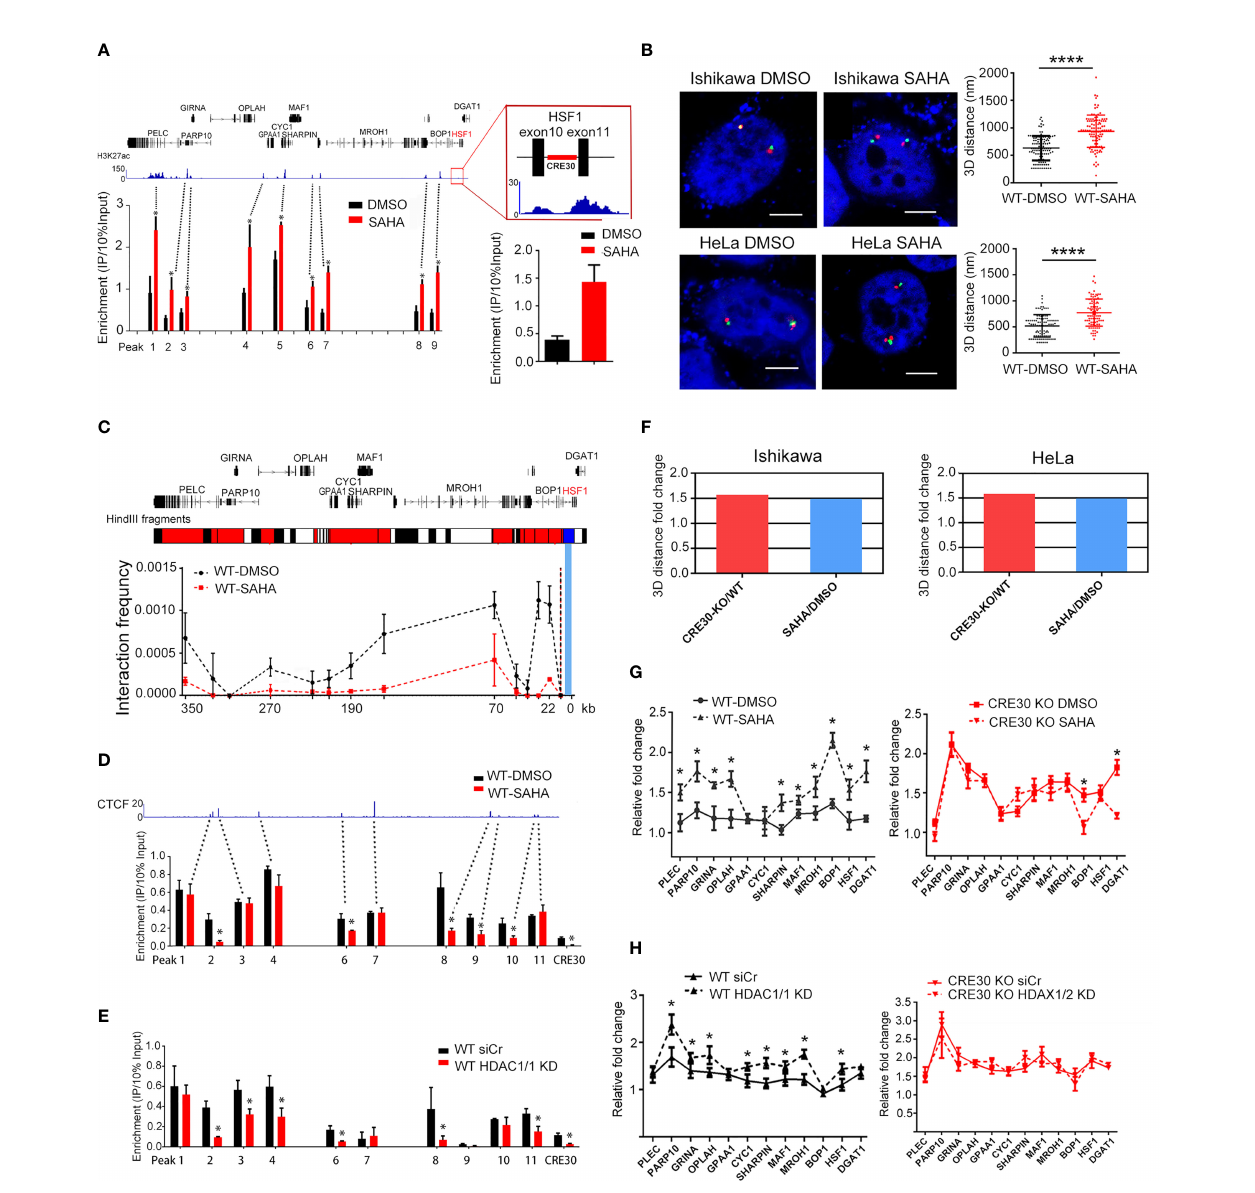
FIGURE 5 | Histone acetylation affects chromatin architecture and regional gene regulation in sub-CRR95. (A) H3K27ac ChIP-qPCR experiments were performed in Ishikawa cells following SAHA treatment. Primers were designed on modi fi cation peak loci obtained from ChIP-seq data in uterus (ENCFF405MES, ENCODE). Peak number corresponds to primers listed in Supplementary Table 1 . A signi fi cant increase of H3K27ac levels was detected in the SAHA treatment group (red bars) compared with the DMSO treatment group (black bars) (n = 3). Right panel zoom in the CRE30 locus. (B) Representative 3D-FISH images of Ishikawa cells (upper panel) and HeLa cells (lower panel) with DMSO or SAHA treatment. Boundary loci of sub-CRR (red and green) and DAPI (blue) are shown. Scale bars indicate 5 m m. Scatter diagrams on the right show the 3D distance between adjacent red and green spots, suggesting a signi fi cant increase after SAHA treatment in both cell lines. Approximately 90 – 120 loci were counted for each group. (C) Analysis by 3C-qPCR in Ishikawa cells at the sub-CRR95 region. The Hind Ш fragment bars on the top illustrate bait fragments (blue) and tested interaction fragments (red). Interaction peaks were detected in the DSMO group (black dotted lines), which decreased with SAHA treatment (red dotted lines) (n ≥ 2). (D, E) ChIP-qPCR assay showed that CTCF binding decreased widely following both SAHA treatment (D) and HDAC1/2 knockdown (E) in Ishikawa wild-type cells (n = 3). Primers designed on CTCF peaks according to ChIP-seq data in Ishikawa (ENCFF961BQG, ENCODE); peak number corresponds to primers listed in Supplementary Table 1 . (F) Based on the 3D distance that is obtained in the same batch of 3D-FISH experiments; fold changes of mean 3D distance were calculated in the CRE30 KO group (CRE30 deletion/wild-type) and SAHA treatment group (SAHA/DMSO). Results in both Ishikawa and HeLa cells are displayed. (G, H) qPCR experiments were performed for wild-type Ishikawa cells following SAHA treatment (G) and HDAC1/2 knockdown (H) . Gene upregulation increased in the wild-type group (left panel) in both conditions, with little or modest change in CRE30 deletion cells (right panel) (n ≥ 2). Asterisks indicate the signi fi cant differences. T-tests were performed, and signi fi cant differences were indicated by * (p < 0.05) and **** (p <